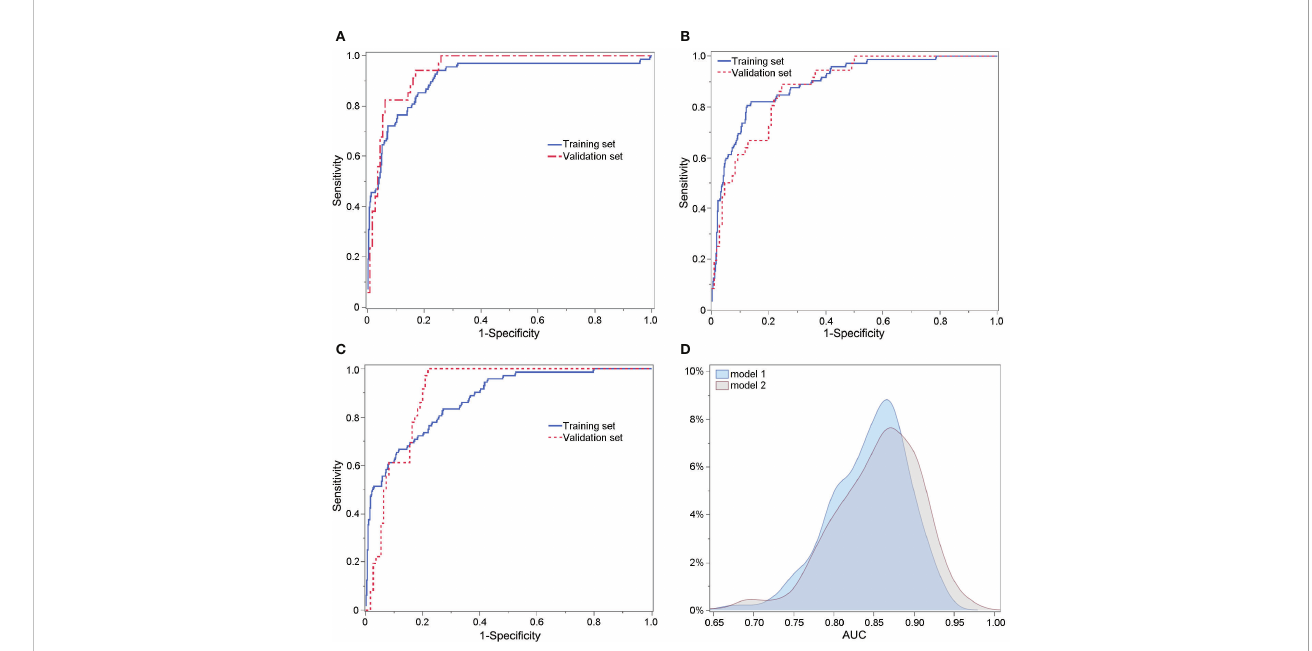
FIGURE 2 ROC curves of Model 1 predicting poor ovarian response (A) , Model 2 (B) and Model 2s (C) for predicting excessive ovarian response. (D) Comparison of the AUCs of Models 2 and 2s using 1000 × bootstrap sampling in the validation